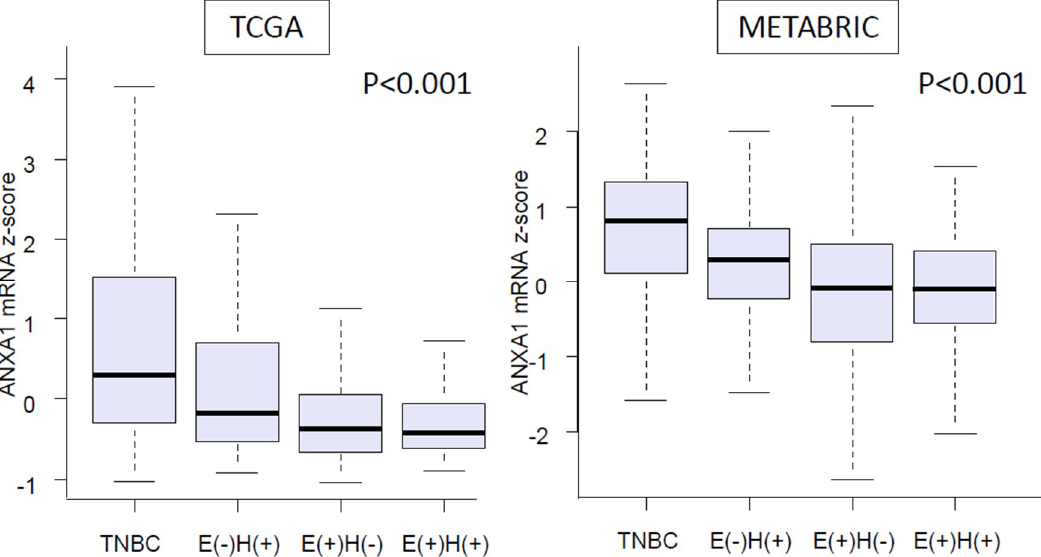
Figure 2. Expression level of ANXA1 mRNA in each subtype of breast cancer samples from a The Cancer Genome Atlas (TCGA) cohort ( n = 1060) and a Molecular Taxonomy of Breast Cancer International Consortium (METABRIC) cohort ( n = 1866). E = estrogen receptor, H = Her2 receptor.